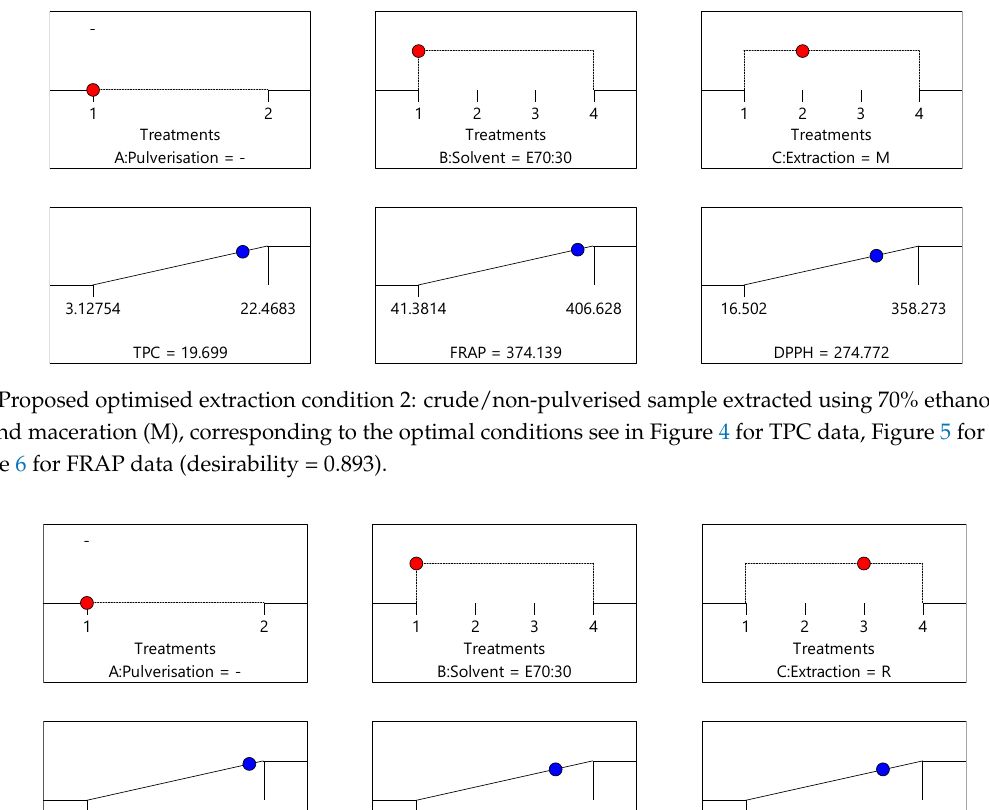
Figure 7. Proposed optimised extraction condition 1: crude/non-pulverised sample extracted using 70% ethanol:30% water (E70:30) and agitation (A), corresponding to the optimal conditions see in Figure 4 for TPC data, Figure 5 for DPPH data, and Figure 6 for FRAP data (desirability = 0.925).